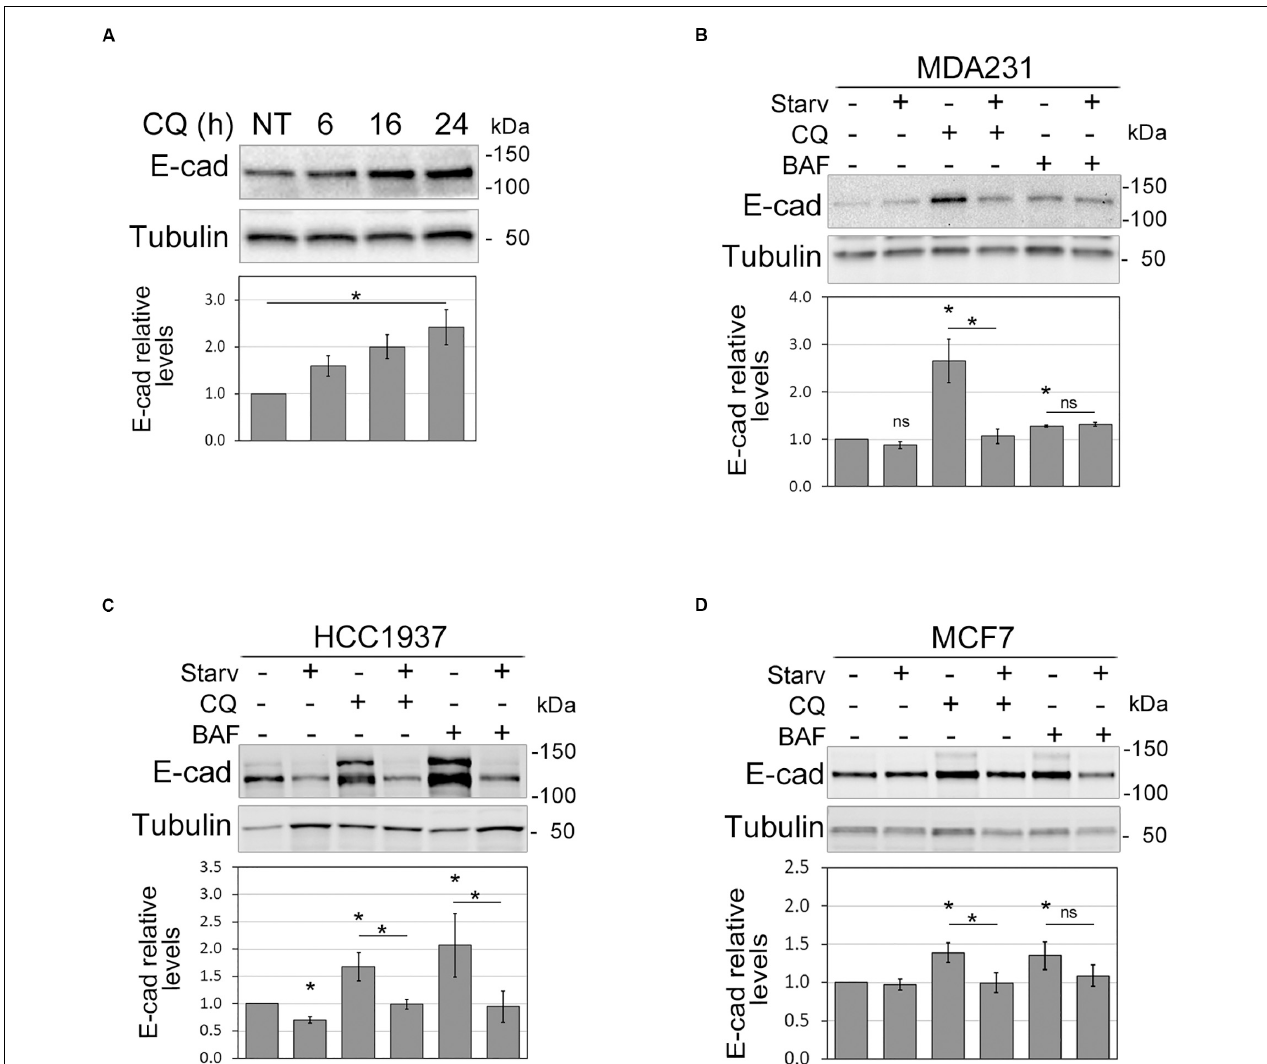
FIGURE 1 | Autophagy modulation affects E-cadherin levels. (A) Immunoblot showing the increment of E-cadherin (E-cad) levels in MDA231 cells treated with CQ for 6, 16, and 24 h. NT represents the untreated cells. γ -tubulin (Tubulin) was used as a loading control. *Statistical significance ( p < 0.01) in the ANOVA test followed by a test for linear trend. (B–D) Representative immunoblots displaying the levels of E-cadherin (E-cad) in MDA231 (B) , HCC1937 (C) , and MCF7 (D) cell lines either treated with CQ or BAF (for 8 h), in standard medium or upon nutrient starvation (Starv). Graphs below blots report the mean of E-cadherin relative levels of three experiments with SEM as error bars. E-cadherin relative levels were obtained by normalization over γ -tubulin (Tubulin, loading control) and rescaling to the untreated sample. The asterisks above the histograms and lines mean statistical significance ( p < 0.05) in the unpaired t -test comparisons to the untreated sample or between indicated samples, respectively. ns, not statistically